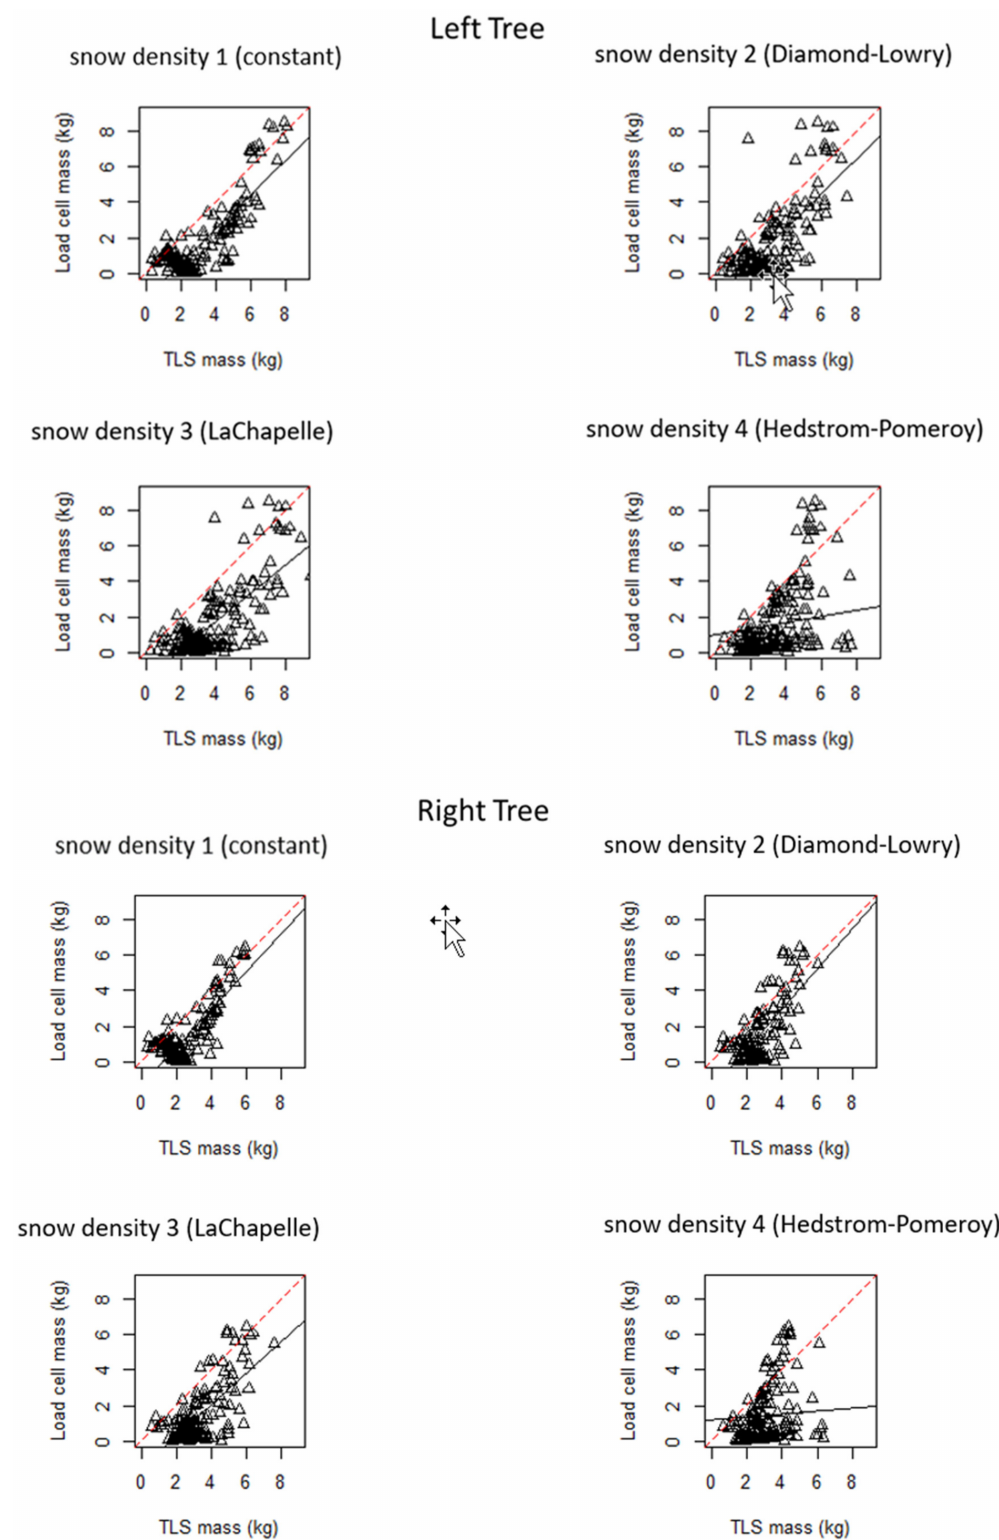
Figure 2. Simple linear regression results comparing predicted (TLS) and measured (load cell) snow interception mass for density estimation Equations (1)–(4) [1,31,32]. Data spans winters 2017–2018. Black lines = regression lines; red lines = 1:1